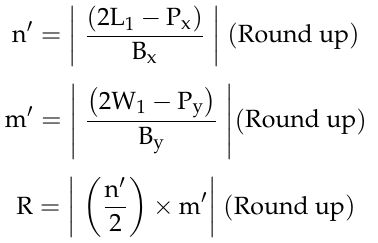
( b ) Figure 8. Horizontal multi-object overlap. ( a ) Before removal. ( b ) After removal. 2.